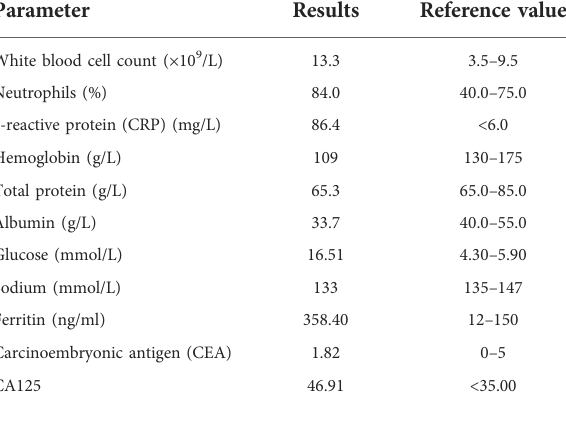
TABLE 1 Patient ’ s laboratory results of blood